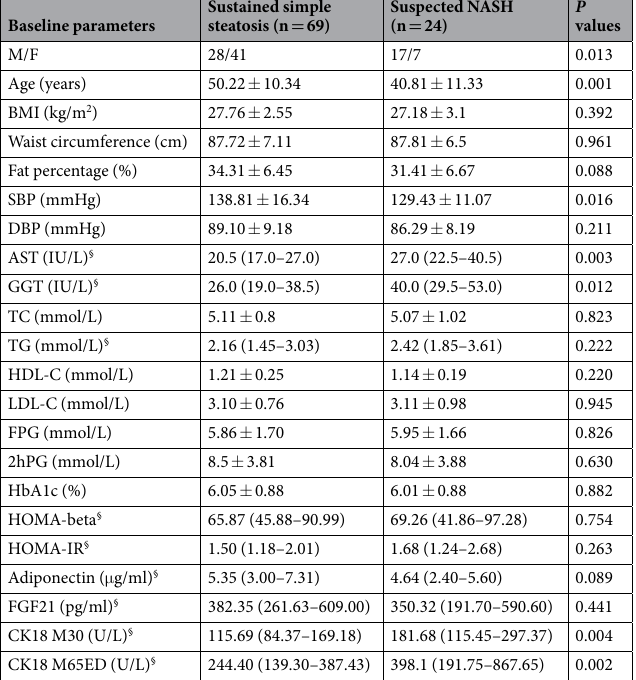
Table 4. Baseline parameters in patients who sustained simple steatosis (n = 69) and patients who developed suspected NASH (n = 24) at follow-up. Data are means ± SD or median (interquartile range). § Ln transformed before analysis.